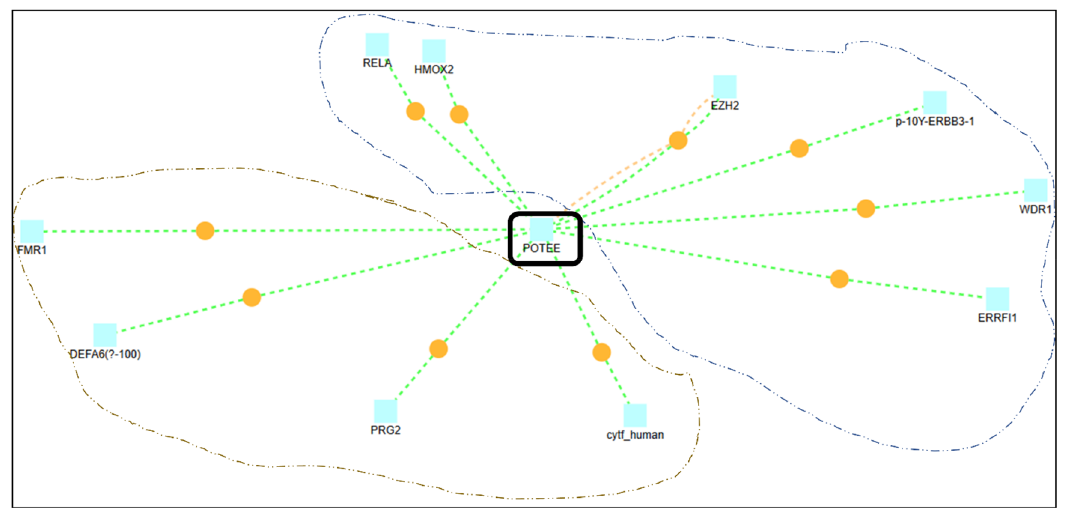
Figure 10: Network dynamics and interactors. Using the k -means clustering algorithm the 10 interactors have been classified into two groups demarcated in blue and orange respectively. Yellow pointer refers to direct and physical interactions of these associators with POTEE.